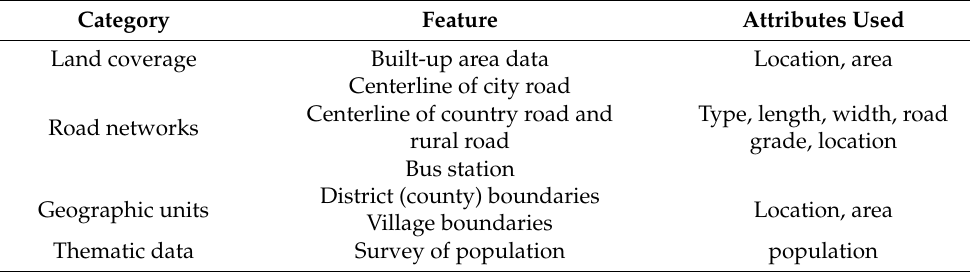
Table 2. List of Wuhan geographical conditions census data used in this study.